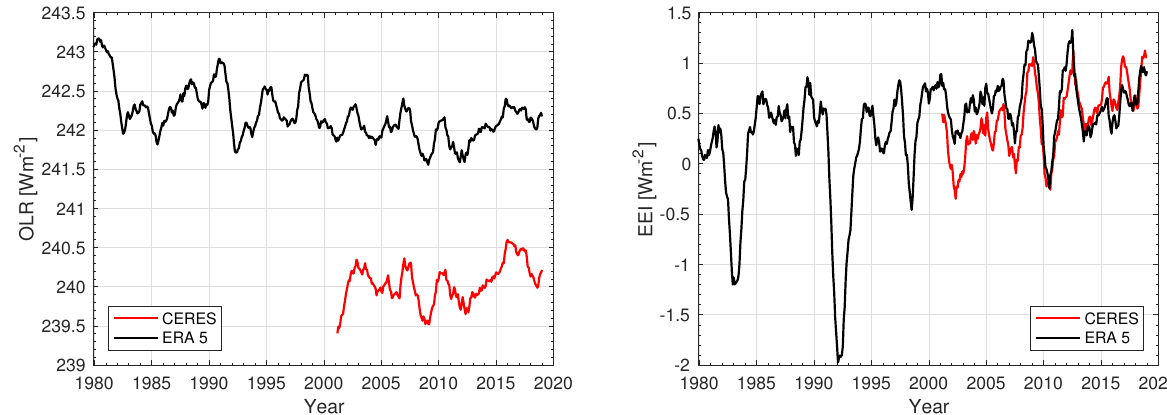
Figure 6. Time evolution of the OLR and the EEI from CERES measurements and the ERA5